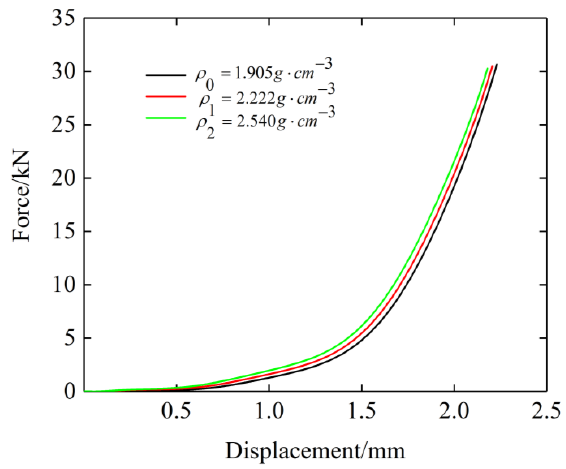
Figure 7. Force – displacement curves of each specimen under different temperatures: ( a ) Specimen 1; ( b ) Specimen 2; ( c ) Specimen 3.